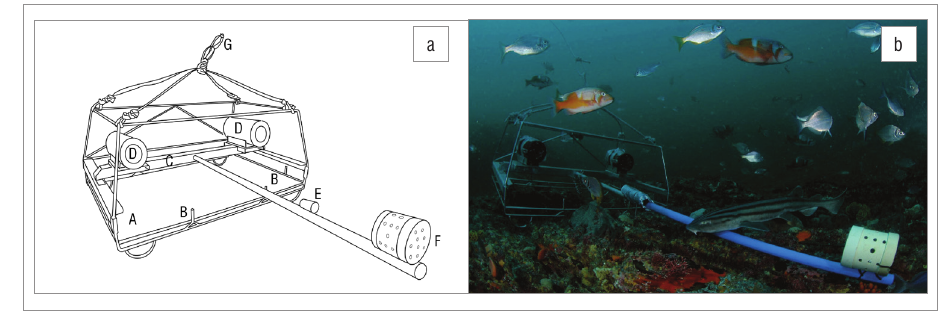
Figure 1: (a) Schematic of a baited remote underwater stereo-video system (stereo-BRUVs) showing stainless steel frame (A) with pins to mount additional weights (B) and rigid centre bar (C) that holds the